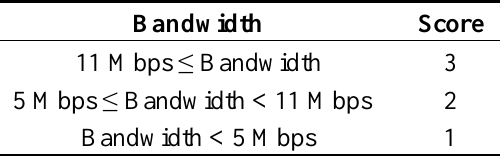
Table 6. The score table of